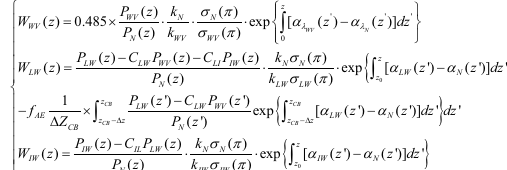
cloudy condition. The left figure corresponds to the results taken at 21:39 CST on 29 Sep, 2018. Two obvious peaks appear at heights of 4.5 km and 5.5 km from the elastic scattering signals. The effective range can reach 6km and 5km for water vapor and liquid water Raman channel, and synchronous grow of water vapor and liquid water in the clouds can be observed. Another measurement example was taken at 22:35 CST on March 4, 2019, as shown in right figure. Two obvious peaks appear at heights of 1-1.2 km (cloud 1) and 2-2.2 km (cloud 2) from the elastic scattering signals, which correspond to the information of thin cloud layers. Fig.1 Diagram of Raman lidar for synchronous three- Fortunately, we can obviously synchronous phase water detection. DM: Dichroic Mirror, IF: increase in the RSCS of water vapor, liquid water Interference Filters, BS: Beam Splitter. and ice water in cloud layer 1 of (cid:794) 1.2km. At the heights of 2-2.2km of cloud layer 2, synchronous growth can also be observed in water vapor and liquid water, however, it has failed to capture the information in ice water because of the weak signal itself, indicating that the Raman lidar system has successfully realized the simultaneous detection of atmospheric water vapor, liquid water and ice water in the